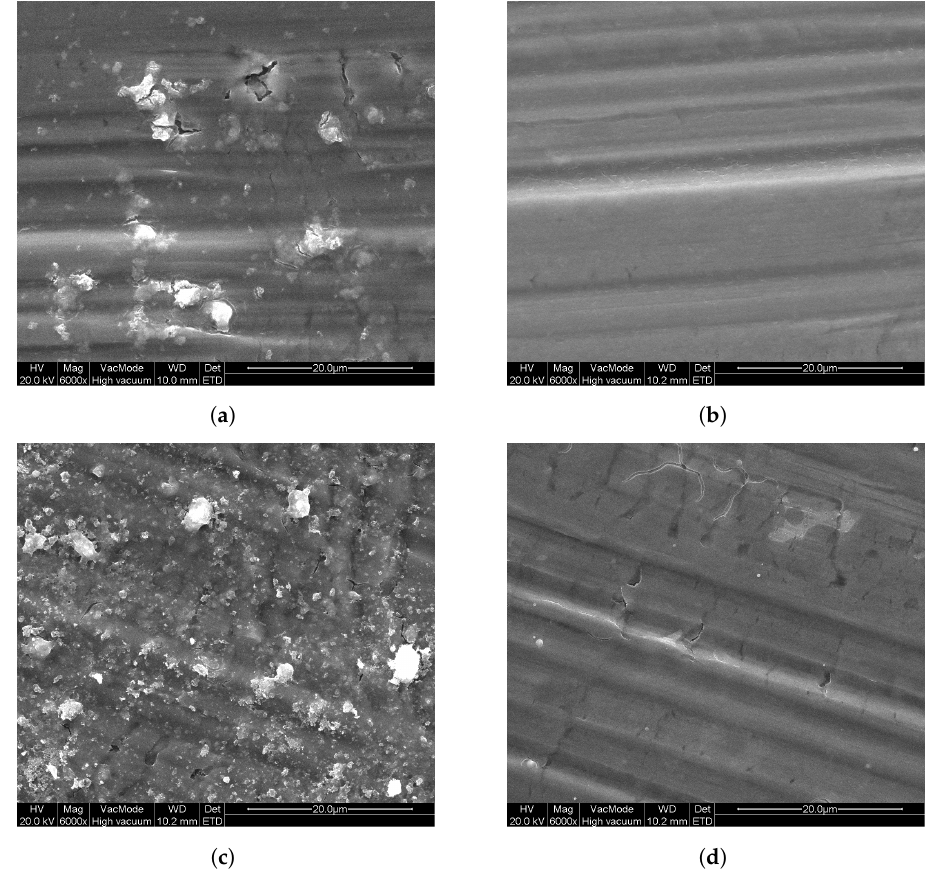
Figure 5. SEM images of the sol–gel TiO 2 coatings on aluminum substrates: ( a ) DC sol–gel P25, ( c ) DC sol–gel ref, ( c ) SC sol–gel P25, and ( d ) SC sol–gel